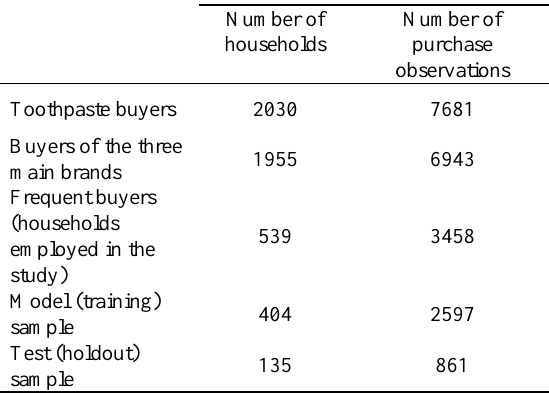
Table 1 Demographic characteristics of the households in